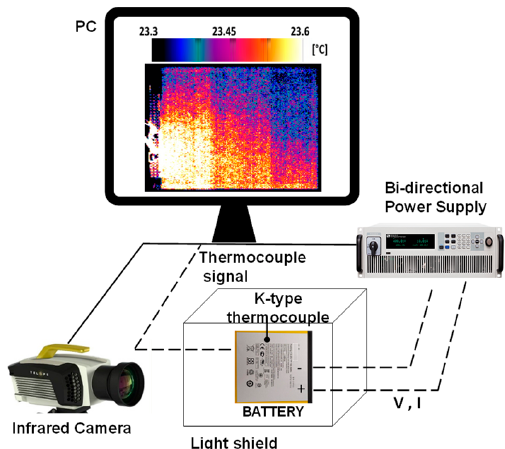
Figure 4. Experimental layout, a photograph of the battery, and a thermal color image.